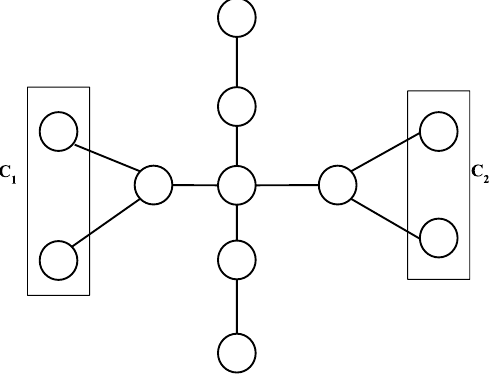
Figure 7. Clusters in M 3 .